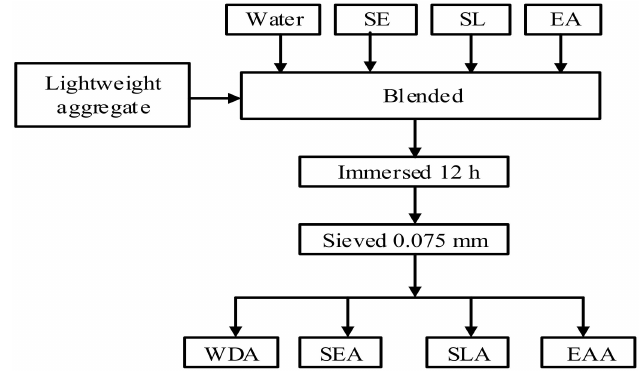
Figure 2. Flow chart of damping aggregate